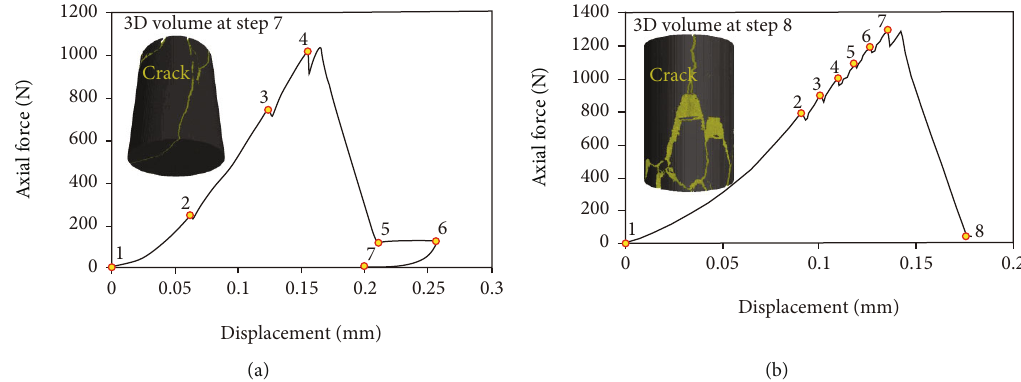
Figure 4: The axial force-displacement relationships and the reconstructed failure 3D volumes at the last scanning steps (the yellow areas are cracks) of S3 (a) and S4